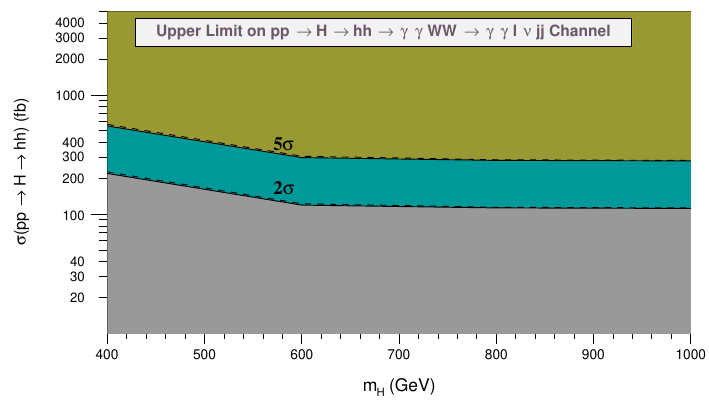
H hh ) (fb) as a function of m H (GeV) for the (cid:13)(cid:13) 1 ‘ 2 j + =E T ! !